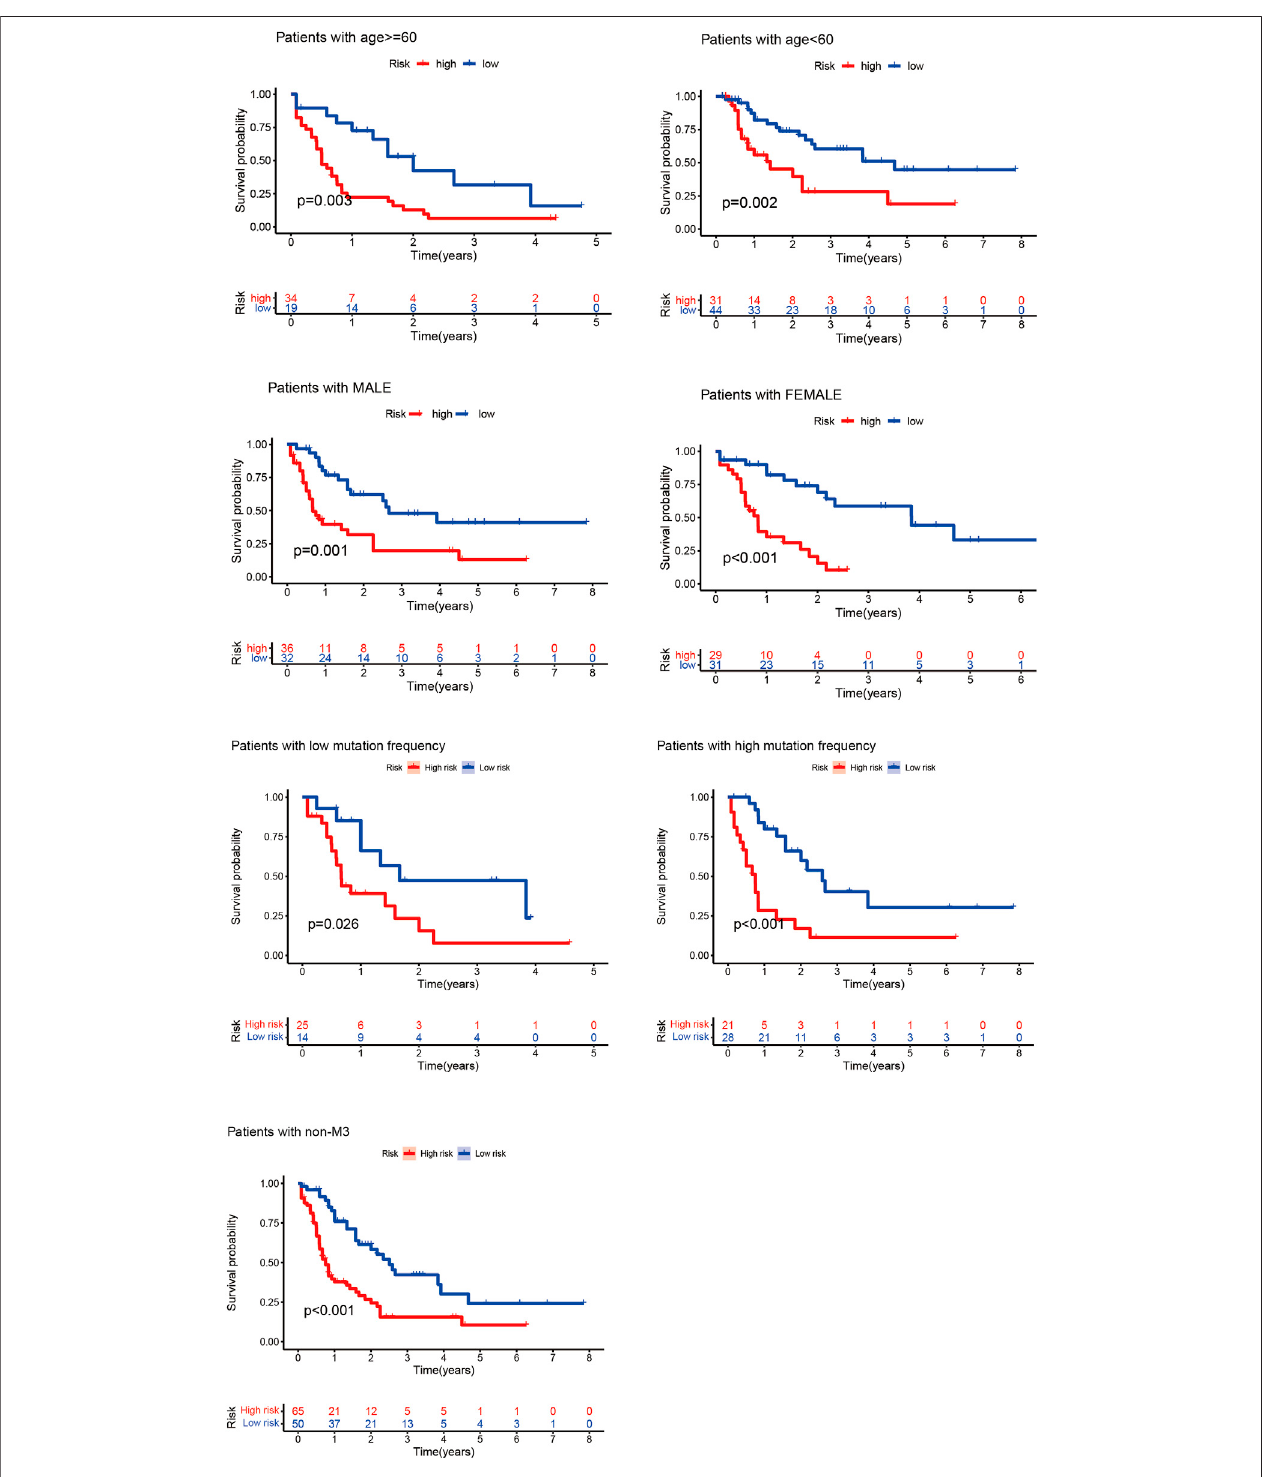
FIGURE 3 | Kaplan – Meier curves of high- and low-risk groups of elderly and non-elderly patients and male and female patients. In the Kaplan – Meier curve of different clinical subgroups ofpatients with AML, the X- and Y -axes represent the time and probability of survival, whereas the red and blue lines represent the high- and low-risk groups,